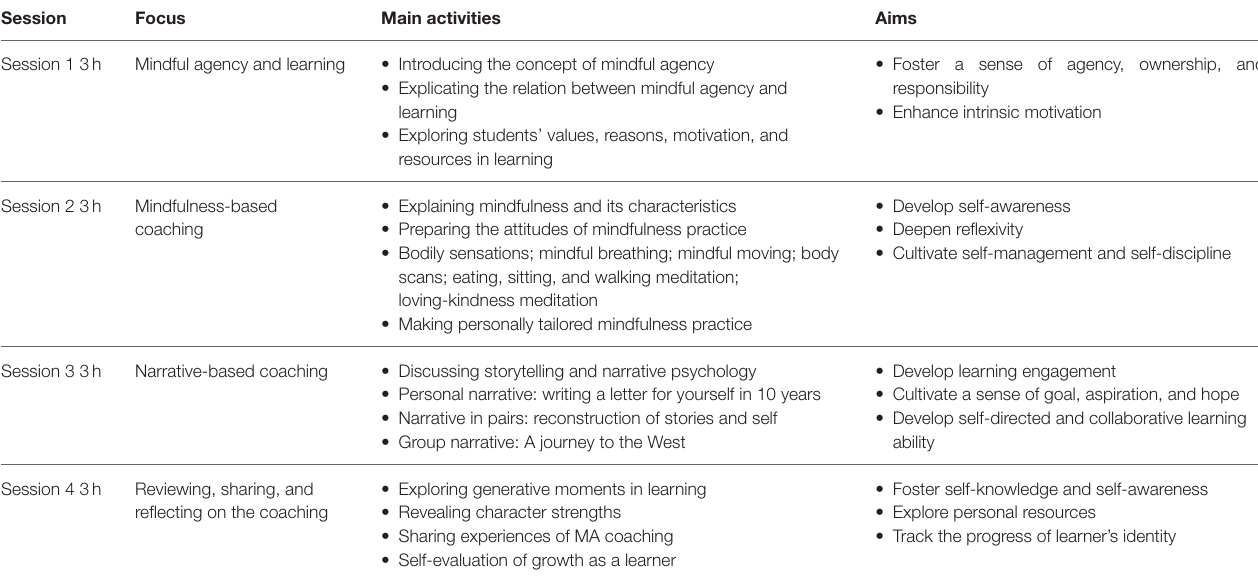
TABLE 1 | Mindful agency coaching